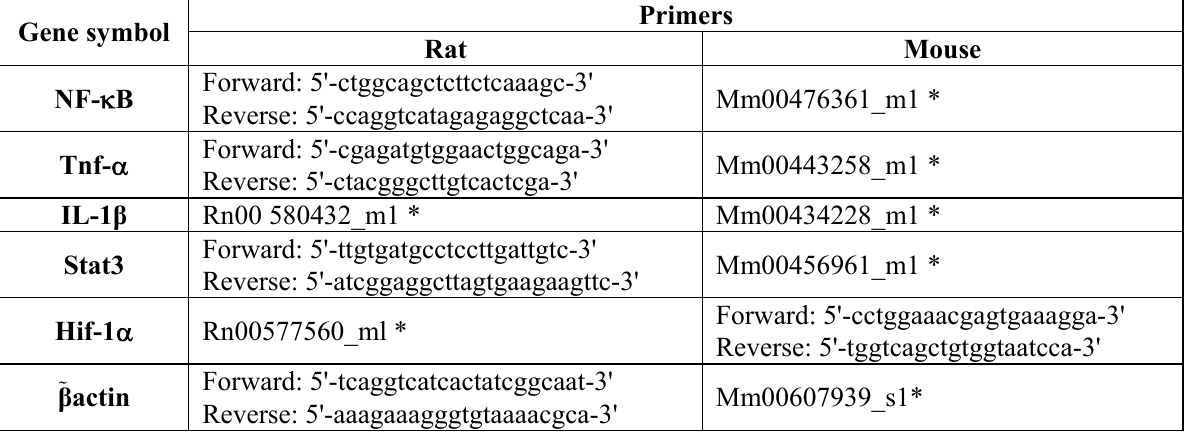
Table 1. Primer sequences used for real-time PCR